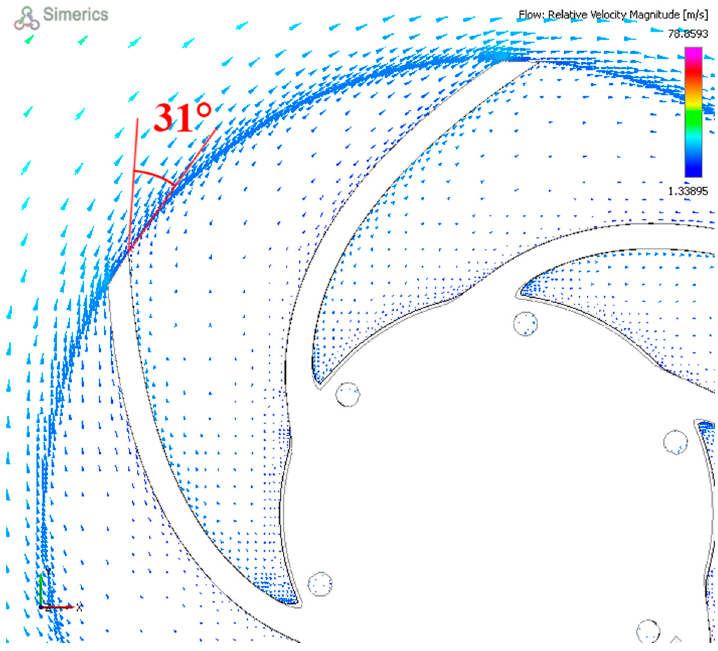
Figure 11. Relative velocity magnitude.